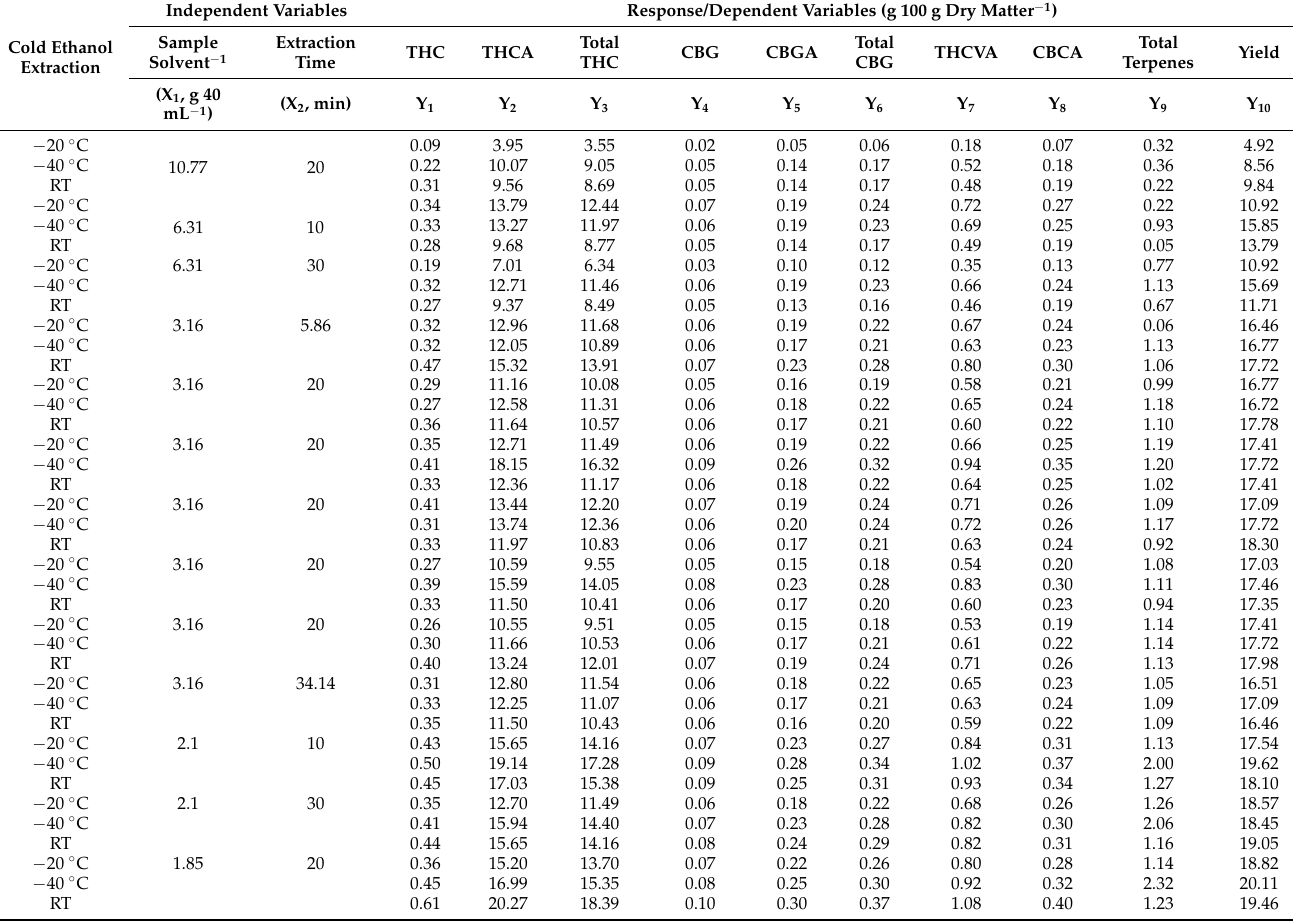
Table 1. Matrix of the central composite rotatable statistical design (CCRD) and observed responses (Yj) for cold ethanol extraction of cannabis biomass at − 20 ◦ C, − 40 ◦ C, and room temperature (RT), with different sample-to-solvent ratios and extraction time.